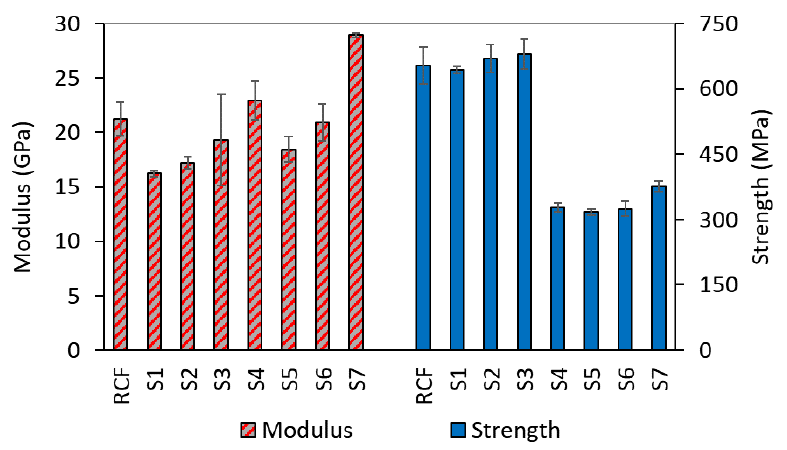
Figure 6. Modulus and strength of the samples at different stages of the plating process. Sample names and their corresponding stages are presented in Figure 1.